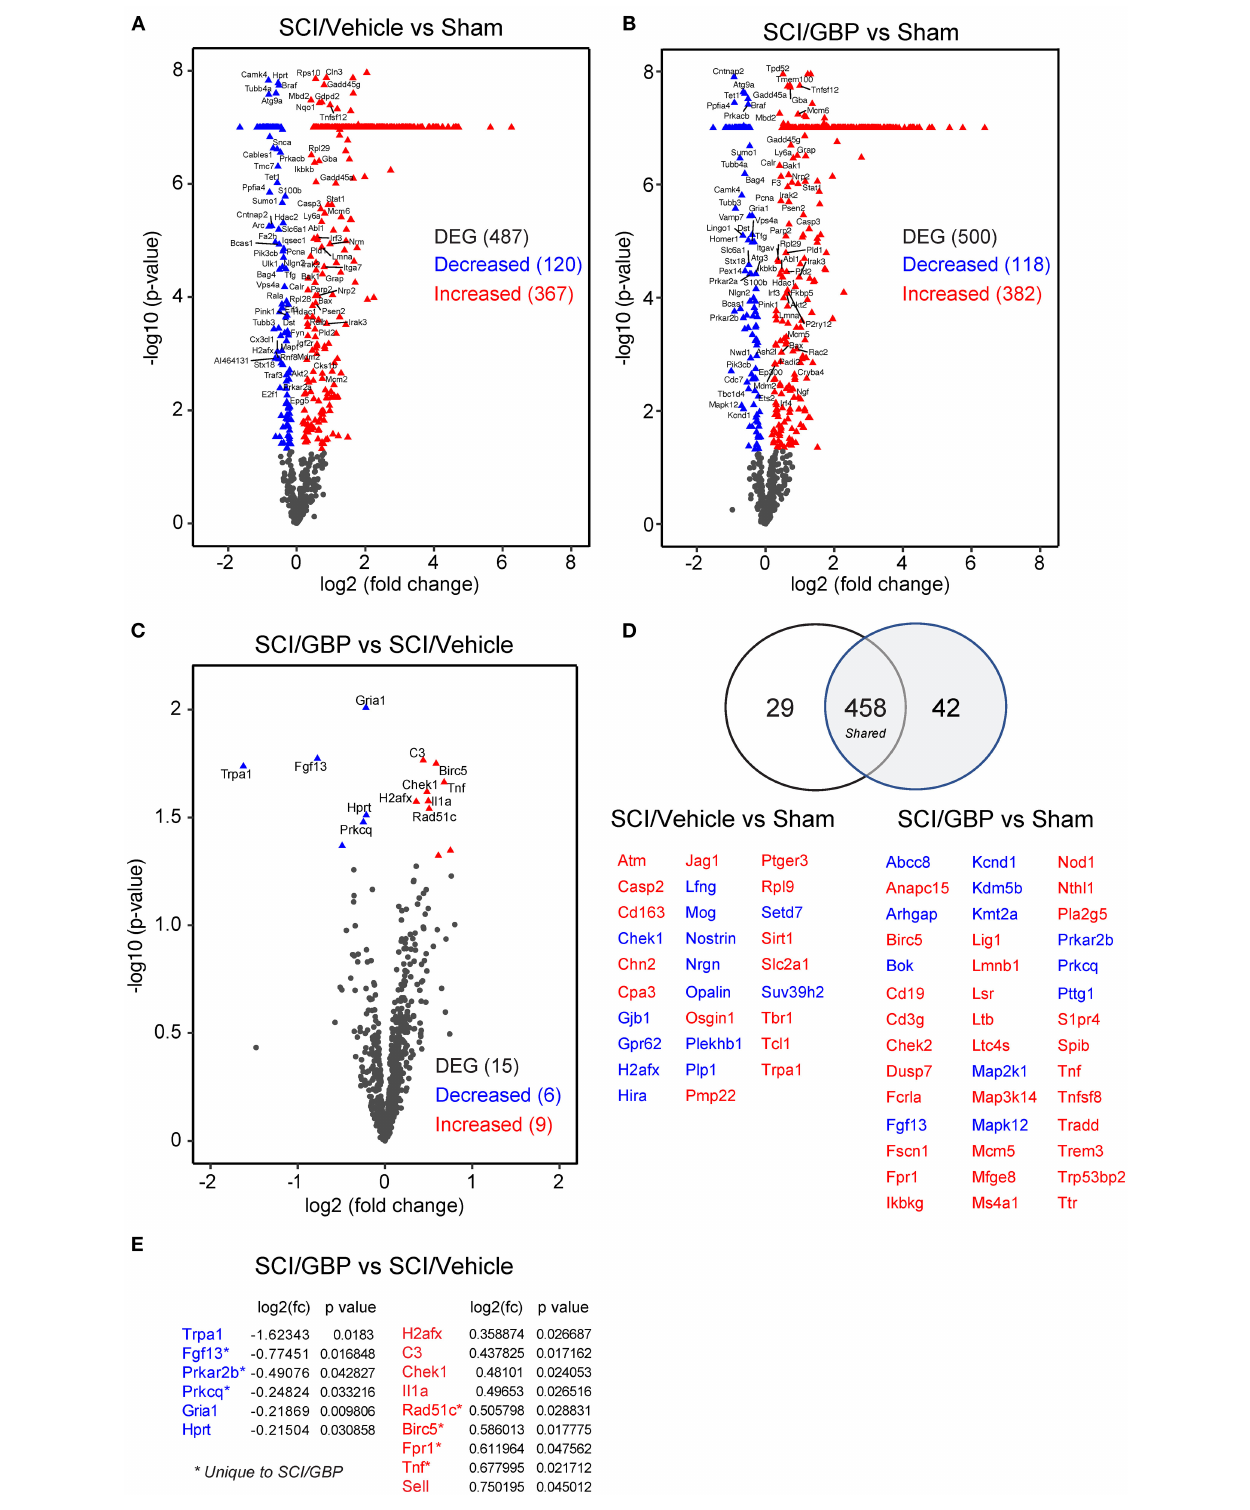
FIGURE 5 | GBP administration does not attenuate neuroinflammatory gene expression. (A–C) Volcano plots of NanoString neuroinflammatory panel. The blue and red triangles represent differentially expressed genes (DEG). (D) The number of DEG in SCI mice administered vehicle and GBP are represented in the Venn diagram. In blue and red are the DEG associated to SCI/Vehicle and SCI/GBP groups. (E) DEG enriched in the SCI/GBP over the SCI/Vehicle group ( p < 0.05).